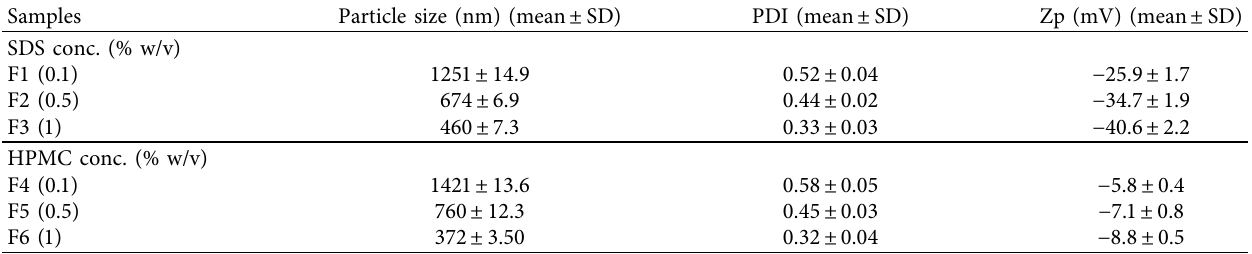
Table 1: Optimization parameters of NAR nanosuspensions stabilized by different concentrations of SDS and HPMC. Samples